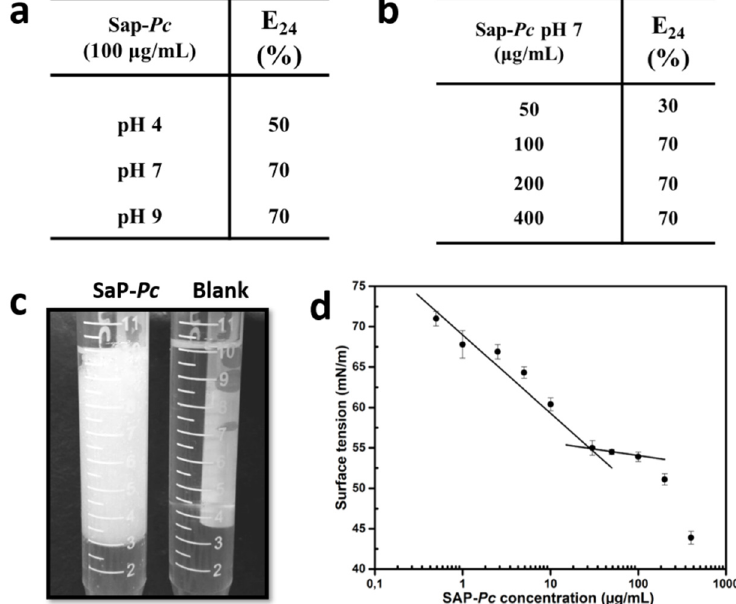
Figure 2. ( a ) Table of E 24 values of 100 μ g/mL of SAP -Pc at different pHs in the presence of Dectol; ( b ) table of E 24 values of SAP -Pc dissolved at pH 7 at different concentrations in the presence of Dectol. All results are averages from three replicate experiments and the standard deviation is less than 10%. ( c ) Emulsion of 100 μ g/mL SAP -Pc in 10 mM phosphate buffer at pH 7 (4 mL) mixed to 6 mL of Dectol after 24 h, in comparison to the mixture of buffer and Dectol, in the absence of the protein. ( d ) graph of surface tension of SAP -Pc in 10 mM phosphate buffer at pH 7 as function of protein concentration.